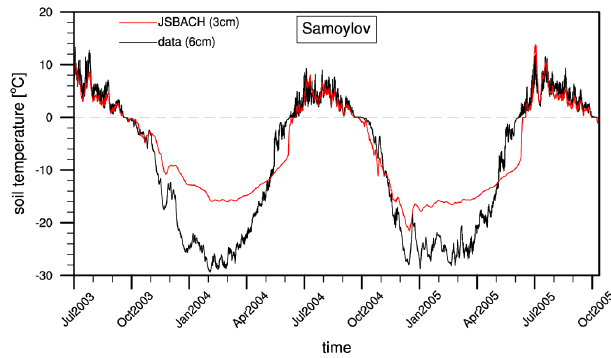
Fig. 6. Observed and simulated soil temperature at the Samoylov site. Observed soil temperature at 71cm is plotted with the black line and the red line shows the JSBACH-simulated soil temperature in the third layer (ca.